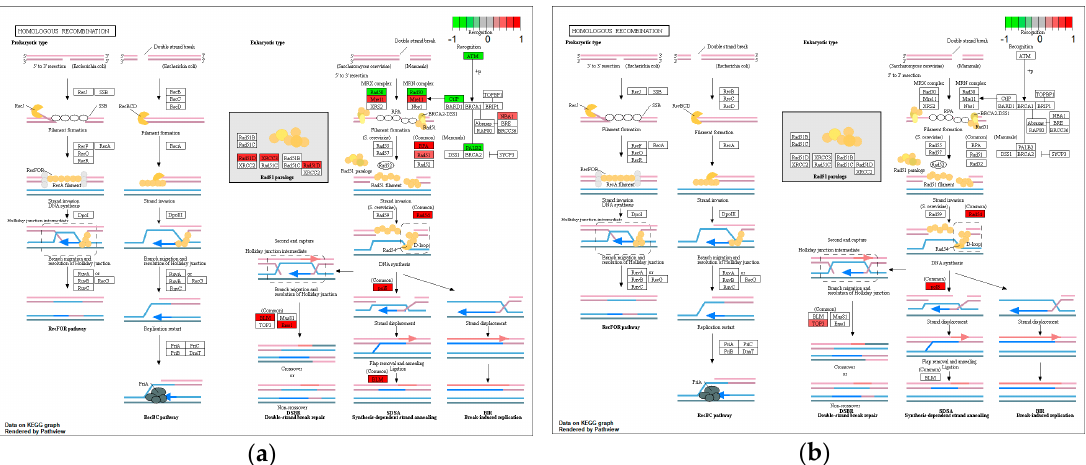
Figure 5. Impact of H. pylori infection ( a ) and CagA protein ( b ) on gene expression of homologous recombination (HR) components, visualized in KEGG pathway map. Components involved in the process are highlighted in red (downregulated) or green (upregulated).